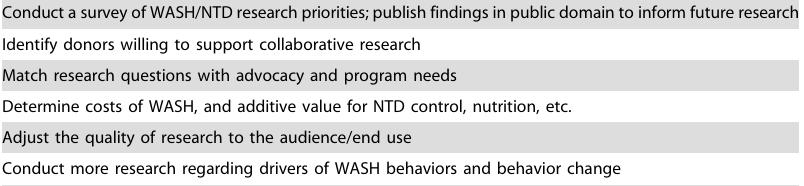
Conduct a survey of WASH/NTD research priorities;publish findings in public domain to inform future